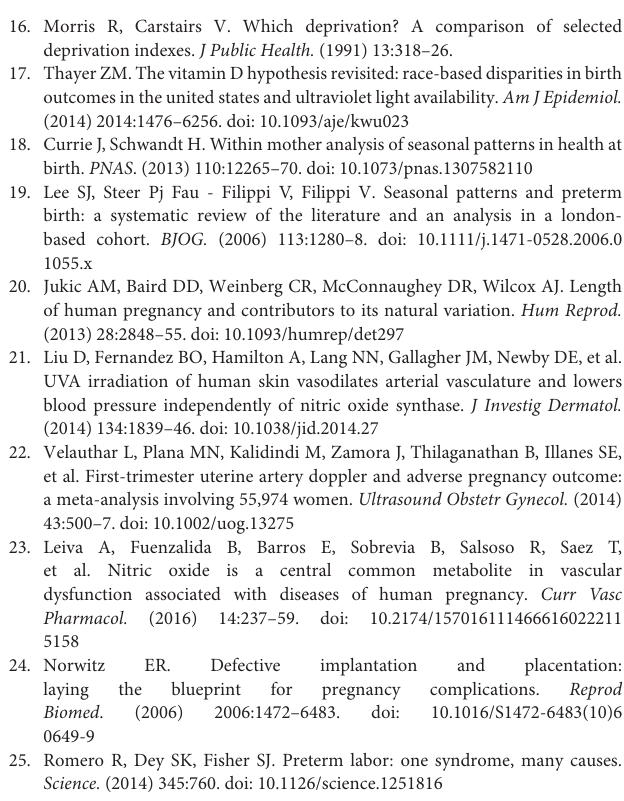
Supplementary Figure 2 | Example of spatial variation in sun availability. Map shows average trimester 1 sun hours per day for pregnancies delivered in 2001 for each 5 × 5 km square in